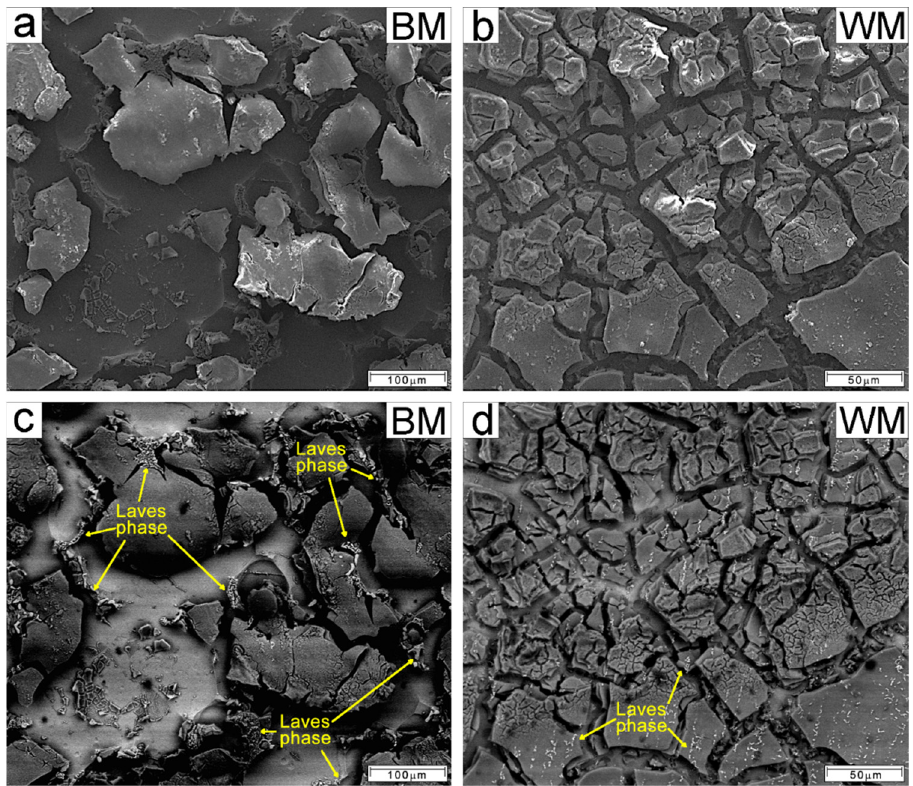
Figure 12. SEM images of the surface morphologies after potentiodynamic polarization in 0.5 M H 2 SO 4 solution for the BM and WM samples. Signal of secondary electrons–SE ( a , b ) and backscatter electrons–BSE ( c , d ), respectively. Table 7. EDS chemical composition analyses of the corrosion product layers attached to the surface of each weld region after potentiodynamic polarization in 0.5 M H 2 SO 4 solution. Weldment